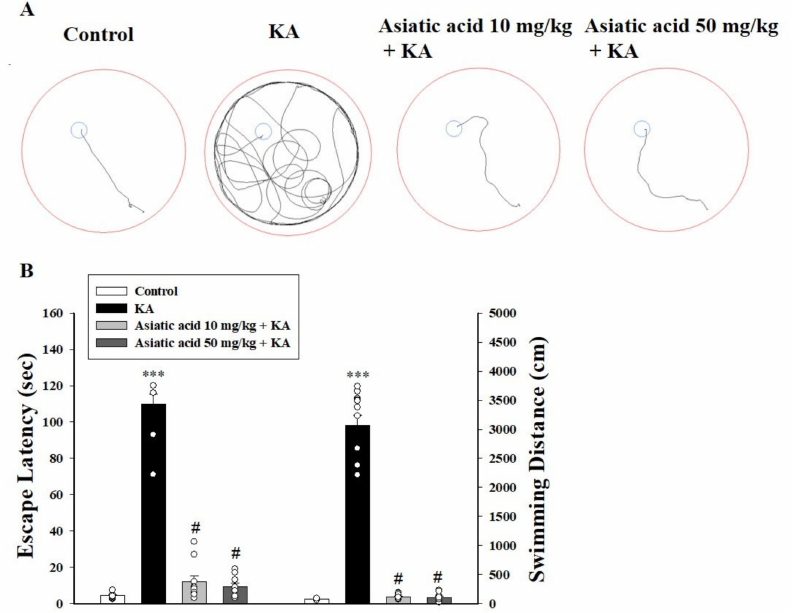
Figure 2. Effect of asiatic acid pretreatment on spatial learning and memory in rats with KA (kainic acid)-induced seizures. ( A ) Swimming tracks of rats in the Morris water maze test. ( B ) Mean escape latency to reach the platform and total distance traveled to reach the platform. *** p < 0.001 (vs. control); # p < 0.001 (asiatic acid + KA vs. KA); n = 8–13 rats per